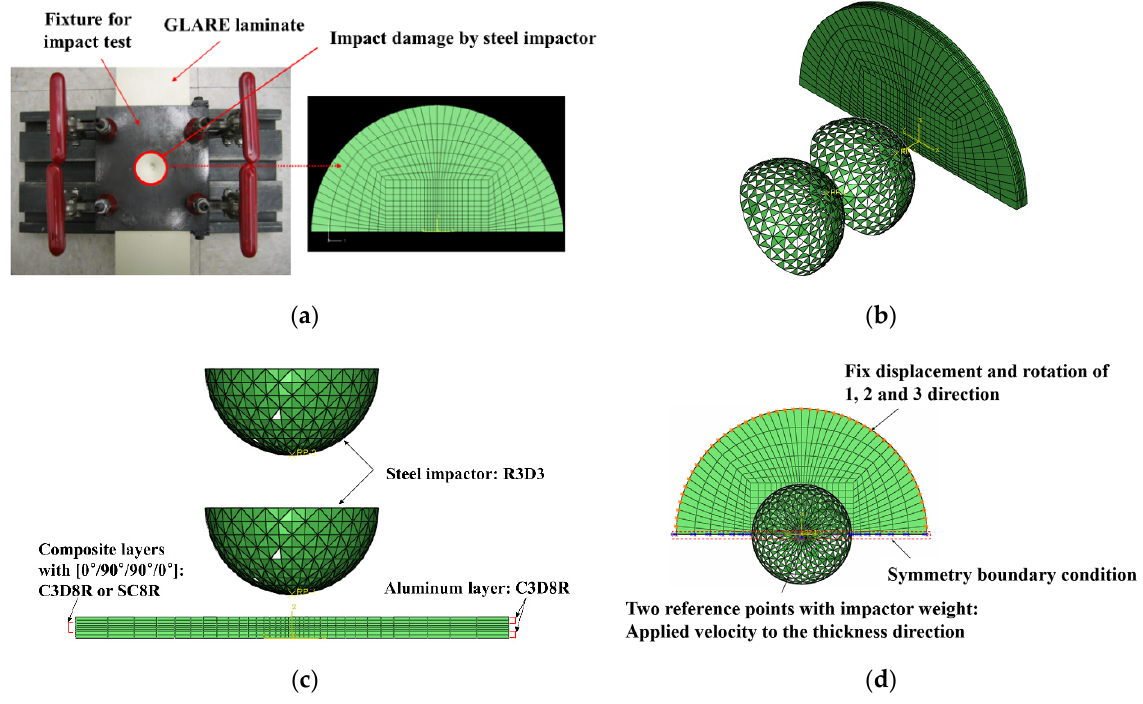
Figure 3. Finite element model and boundary conditions for GLARE 5-2/1: ( a ) finite element model and clamping fixture, ( b ) cross view of mesh geometry with multiple hemispherical impactors, ( c ) side view of mesh geometry with multiple hemispherical impactors, ( d ) boundary conditions of finite element